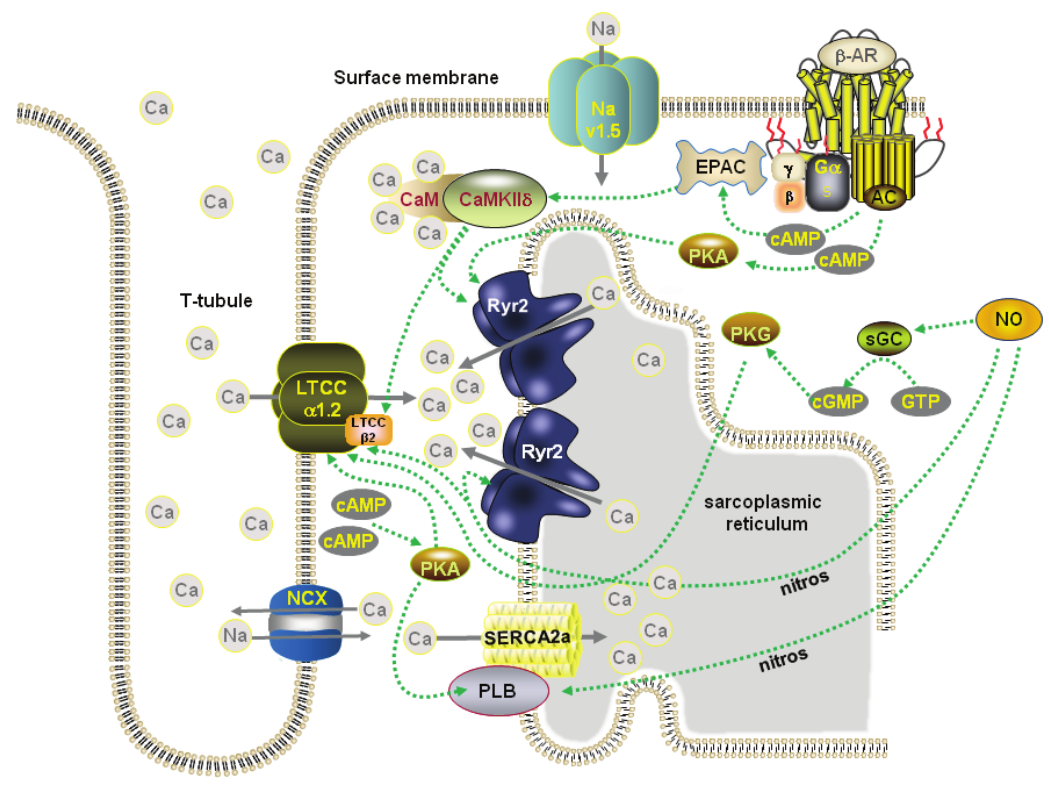
Figure 1. Schematic diagram of the main proteins involved in EC coupling in a ventricular myocyte and the main mechanisms for their phosphorylation or nitrosylation. LTCC = L-type Ca channel, Cav1.2; Nav1.5 = cardiac isoform of the Na channel; NCX = Na/Ca exchange; Ryr2 = ryanodine receptor; PLB = phospholamban; AC = adenylyl cyclase; sGC = soluble guanylyl cyclase; EPAC = exchange protein activated by cAMP; PKA = protein kinase A; PKG = protein kinase